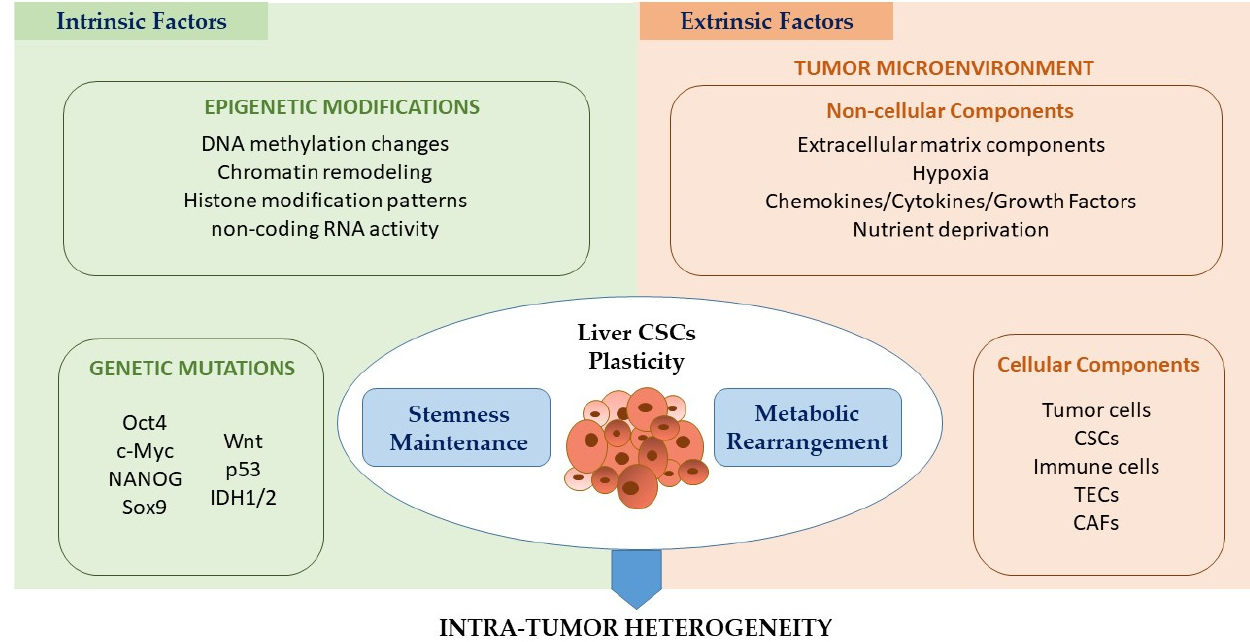
Figure 2. Schematic representation of intrinsic and extrinsic cues that contribute to CSC plasticity. CSC plasticity can be controlled by several cell-intrinsic and cell-extrinsic cues. Intrinsic factors include genetic mutations of various transcription factors/genes (e.g., Oct4, c-Myc, NANOG, Sox9, Wnt, p53, IDH1/IDH2) and epigenetic variations (e.g., DNA methylation changes, chromatin remodeling, histone pattern modification and non-coding RNA activity). On the other hand, the extrinsic factors are related to the surrounding tumor microenvironment (TME), which consists of heterogeneous cell populations (e.g., CSCs, more differentiated tumor cells, infiltrating immune cells and other stromal cells) and non-cellular components (e.g., ECM, hypoxia, nutrient-deprived conditions, several released cytokines, growth factors, metabolites, etc.0d). All these factors differentially fuel the plasticity of liver CSCs, regulating stemness maintenance and the metabolic rearrangement of liver